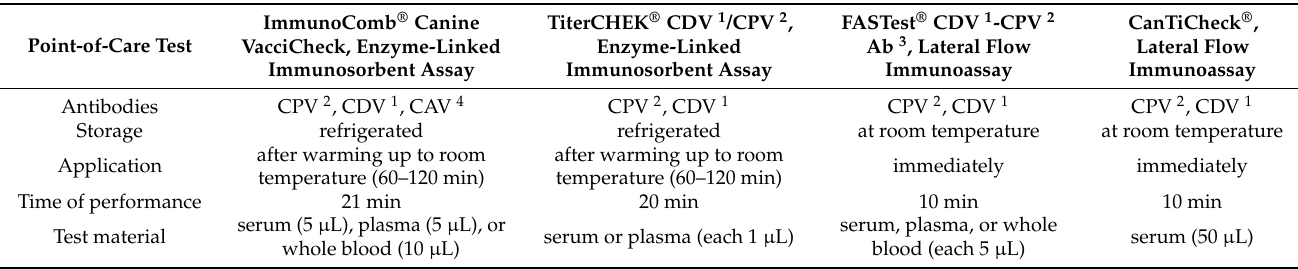
Table 1. Manufacturers’ instructions of the four point-of-care tests for detection of anti-canine parvovirus antibodies. Data on antibodies against canine distemper virus and canine adenovirus were not subjects of the present study. Point-of-Care